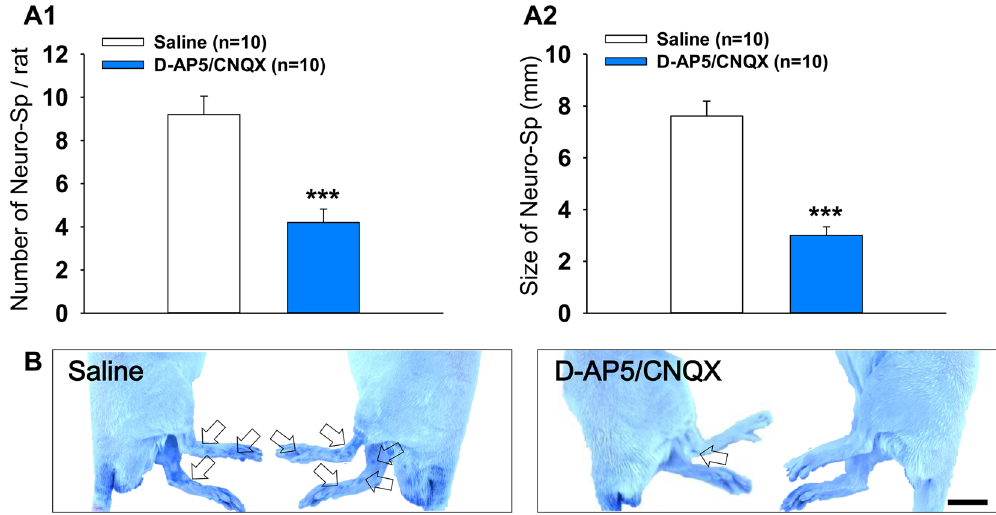
Figure 6. Reduction in Neuro-Sps by intrathecal D-AP5/CNQX in MO-infused rats. ( A ) Number (A1) and size (A2) of Neuro-Sps (n = 10) following an intrathecal injection of D-AP5/CNQX in MO-infused rats. *** p < 0.001 vs. Saline. ( B ) Representative images of Neuro-Sps comparing saline control to D-AP5/CNQX treatment. Bar = 20